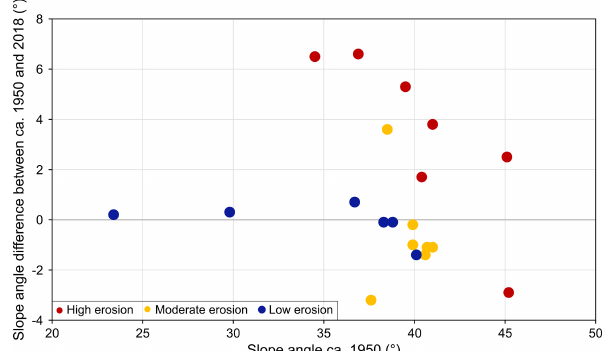
Figure 15. Change in the slope angle between ca. 1950 (1953/1954/1959/1960, depending on the DEM) and 2018 for the upper slopes of the investigated moraine sections. Colouring of the dots represents the mean erosion rates of the DoDs in time period 3 (see Table 4 for specific DoDs; erosion rate of 0–2cmyr − 1 in blue, 2–4cmyr − 1 in orange, and > 4cmyr − 1